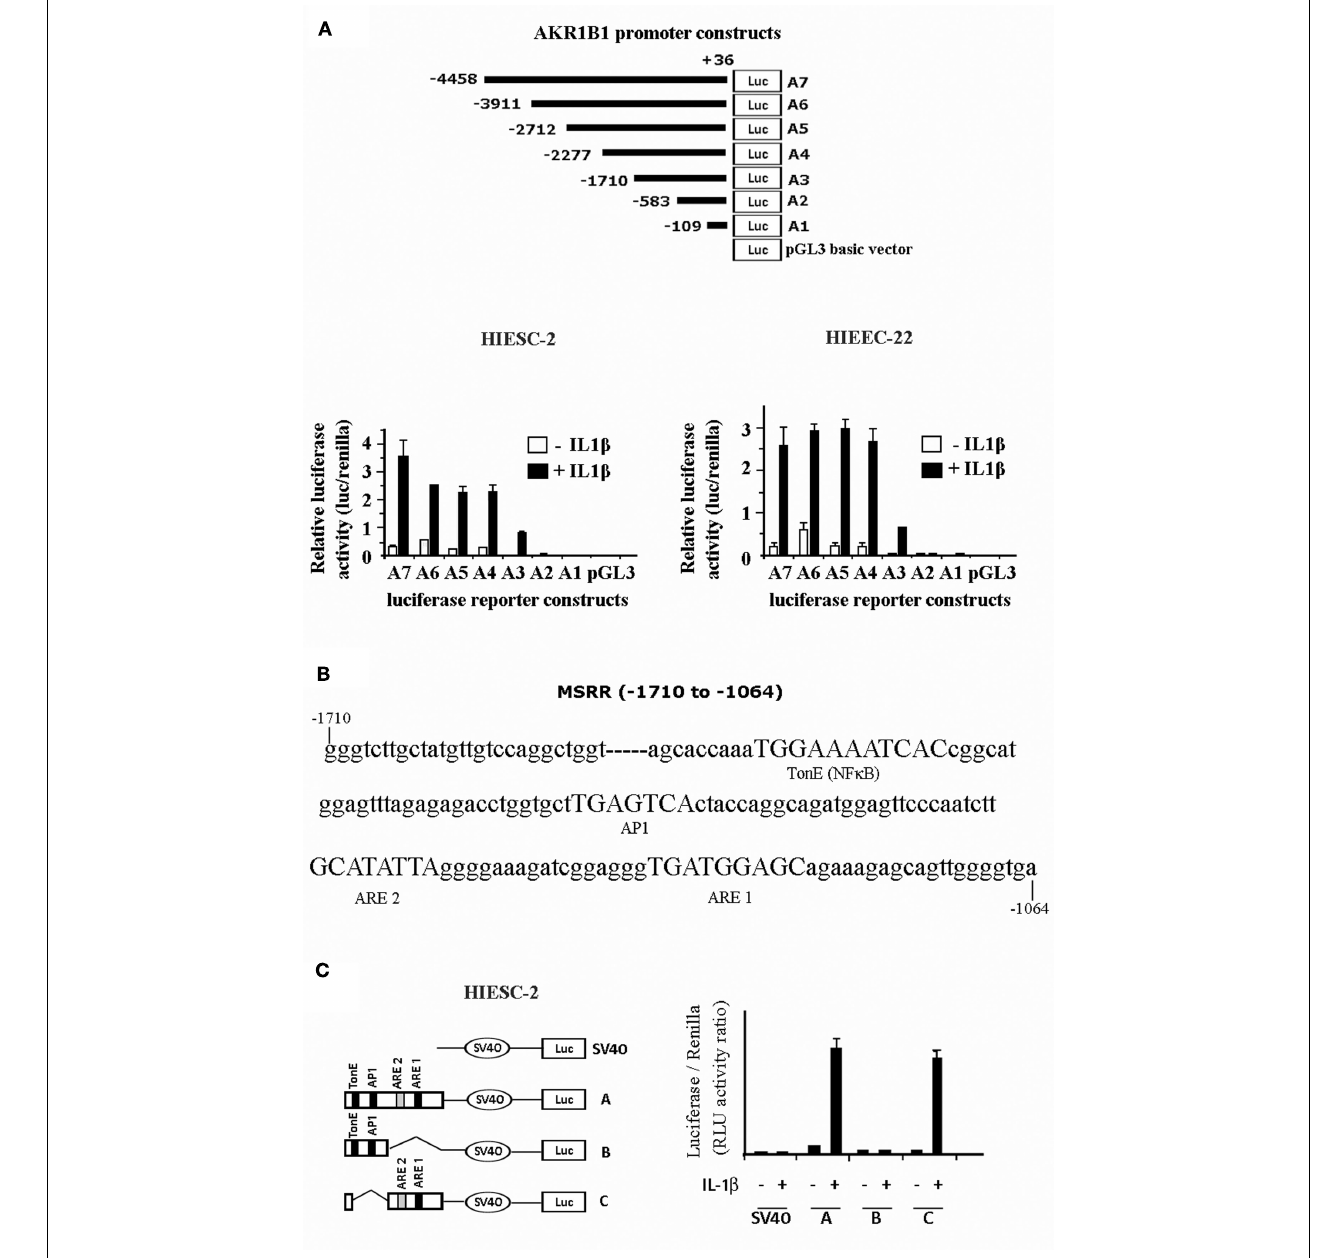
region ( − 1710 to − 1064) showing the organization of the important cis-elementsTonE (NF κ B), AP1 and anti-oxidant response elements 1 and 2 (ARE1 and ARE2). (C) Relative activity of MSRR cis-elements of the AKR1B1 promoter following stimulation with IL-1 β of transfected stromal endometrial